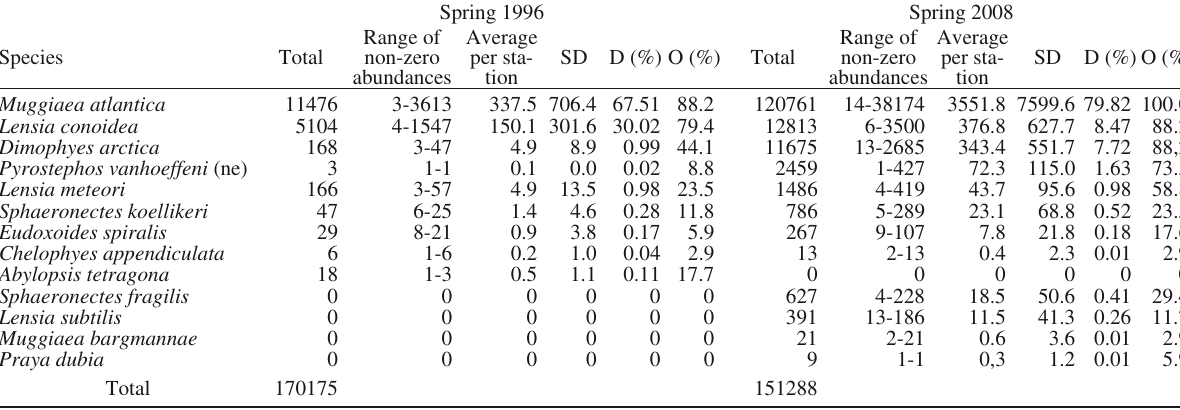
Table 4. – Summary of basic statistics for polygastric stages of siphonophores between the springs of 1996 (CIMAR 2 Fiordos cruise) and 2008 (CIMAR 14 Fiordos cruise). Total number of individuals, range of abundances, average abundance per station, standard deviation (SD), dominance (D) and occurrence (O). Abundances are expressed as number of individuals per 1000 m –3 . Ne,